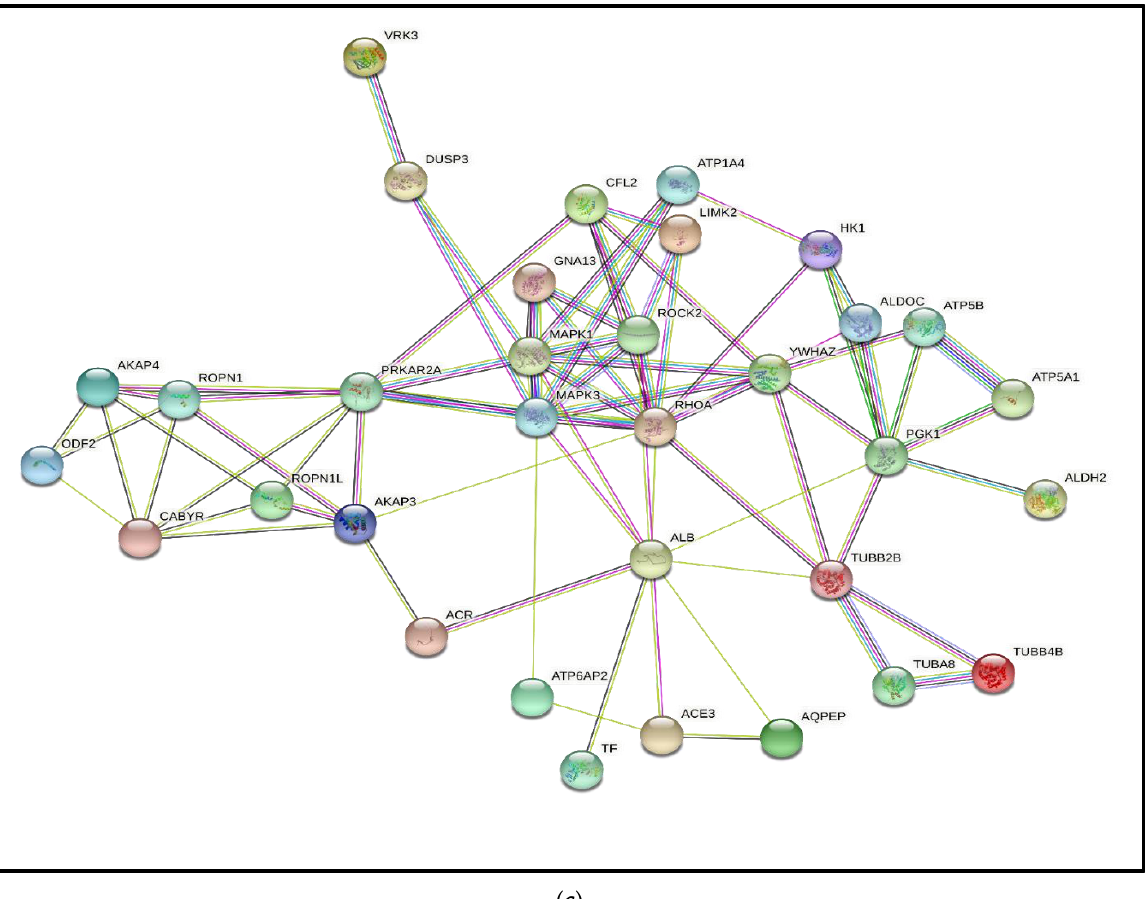
Figure 2. Protein–protein interaction (PPI) network of identified interactome constituents that remained associated with tACE (Testis Angiotensin Converting Enzyme) in fresh ( a ) and capacitated ( b ) bovine sperm, in addition to a comprehensive hypothetical interactional network ( c ). The network was generated through STRING v11.5 using Bos taurus taxonomy. Interactions are characterized by the number and color of interconnecting lines representing the strength and source of evidence of predicted associations with novel associations identified after capacitation that generated continuity within the network [PPI enrichment p -value in fresh sperm ( a ) = 0.000729; PPI enrichment p -value after capacitation ( b ) = 6.15 × 10 −6 ; PPI enrichment p -value with presumed constituents elucidated from additional nodes to network to generate continuity ( c ) < 1.0 × 10 −16 ]. AKAP3: A-Kinase